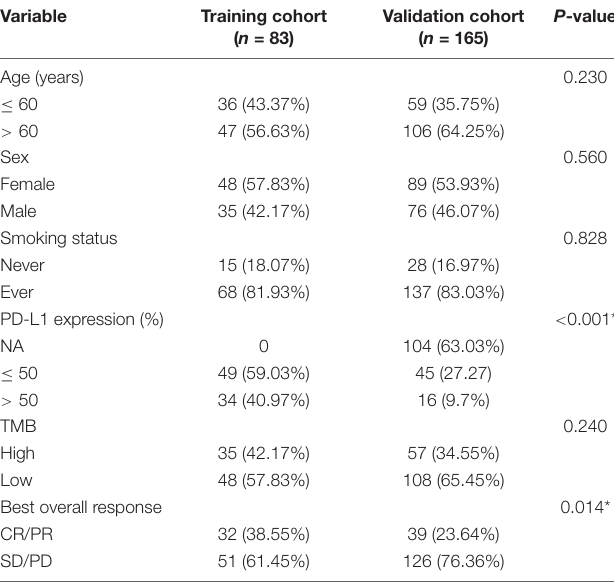
TABLE 1 | Characteristics of patients in the training and validation